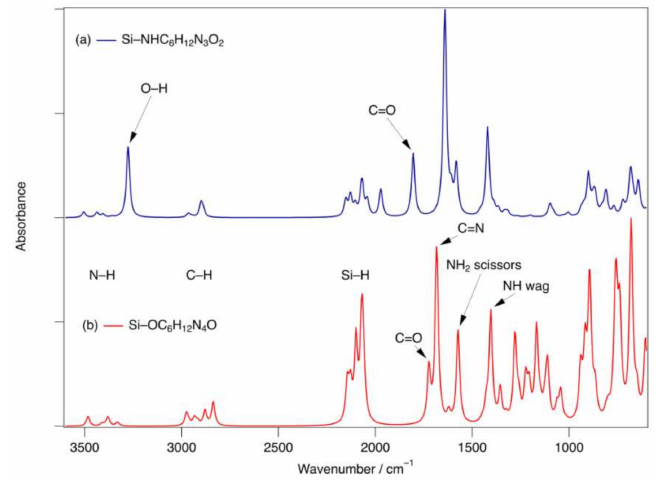
Figure 6. ( a ) Simulated FTIR spectrum of Si–N bound arginine. Note the prominent stretch of free OH at 3276 cm –1 and the distinct C=O carbonyl stretch at 1804 cm –1 . ( b ) Simulated FTIR spectrum of Si–O bound arginine. Note the more congested region from 1400–1700 cm –1